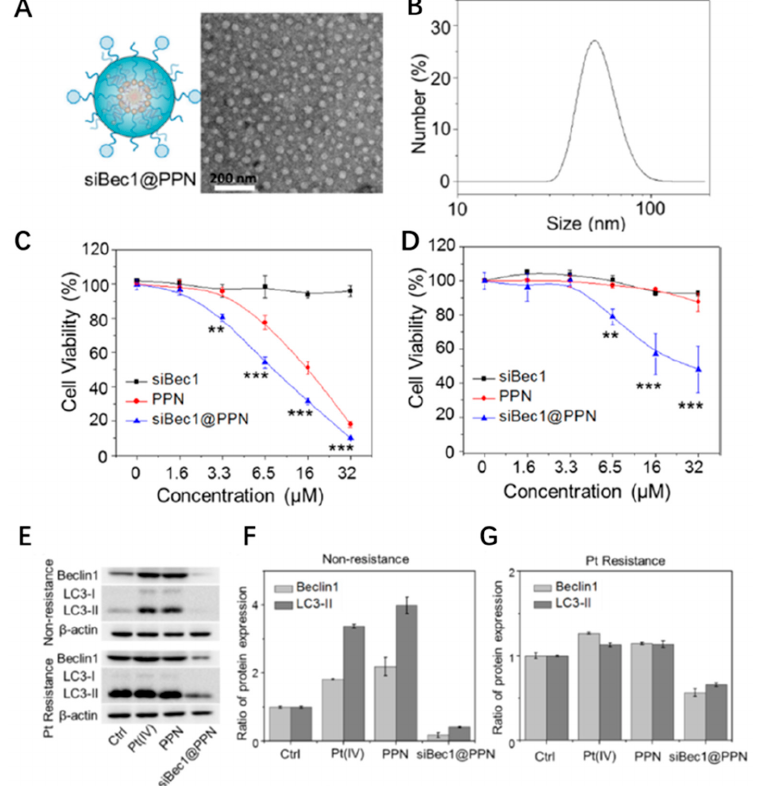
Figure 2. siBec1@PPN-enhanced apoptosis and reversed drug resistance by exploiting autophagy inhibition induced through silencing Beclin 1. ( A ) Schematic and TEM images of siBec1@PPN. ( B ) Size distribution of siBec1@PPN in pH 7.4 PBS buffer detected by DLS. Cell viability results of ( C ) normal A549 tumor cells and ( D ) Pt-resistant A549 tumor cells treated with siBec1, PPN, and siBec1@PPN for 48 h. siBec1@PPN-induced autophagy inhibition and intracellular GSH scavenge. n = 3; ** p < 0.01; *** p < 0.001. ( E ) Western blot of Beclin1 and LC3-II in A549 tumor cells or Pt-resistant